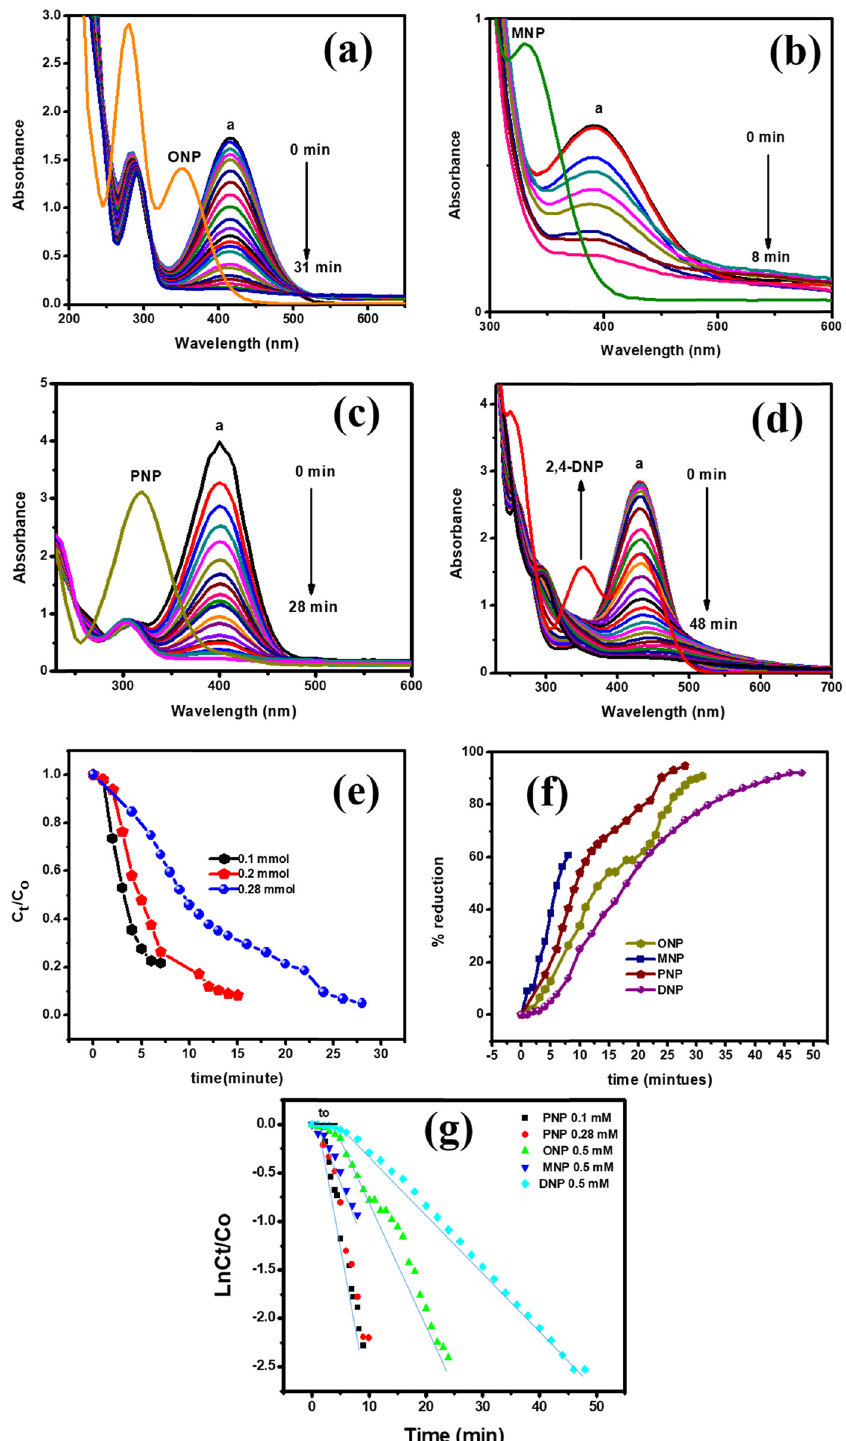
Figure 3: Time - dependent UV - Vis spectrum for the reduction of ONP ( a ) , MNP ( b ) , PNP ( c ) , and DNP ( d ) , the labeled a in the spectrum ( a – d ) showing the phenolate ion, which is formed after the addition of NaBH 4 , while the pure nitrophenol is designated by their name in the spectrum ( a – d ) , kinetic data C t / C 0 for the di ff erent concentration of PNP ( 0.1, 0.2 and 0.28 mM ) ( e ) and % reduction of all nitrophenols ( f ) . ONP, MNP, and DNP are 0.5 mM while the PNP in the % reduction graph is 0.28 mM, the k app value and R 2 value deduced from the linear equation ln C t / C 0 ( g )